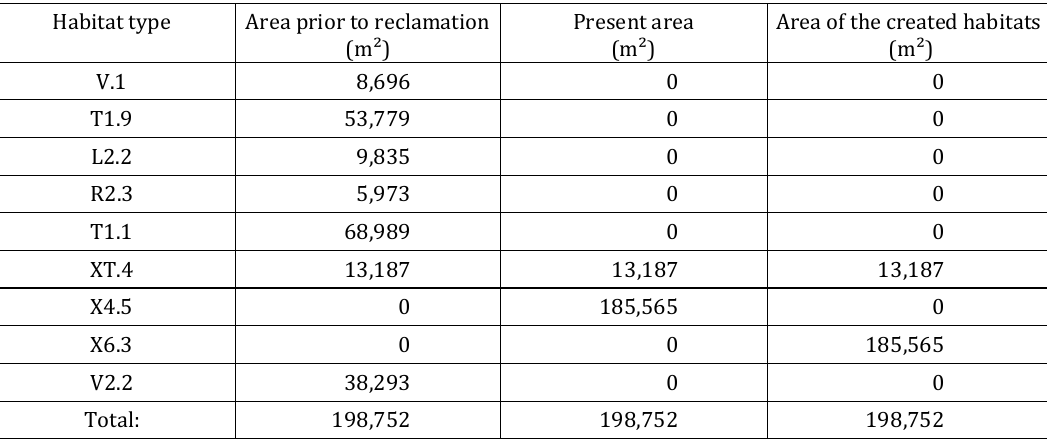
Table 3. Area of the distinguished natural